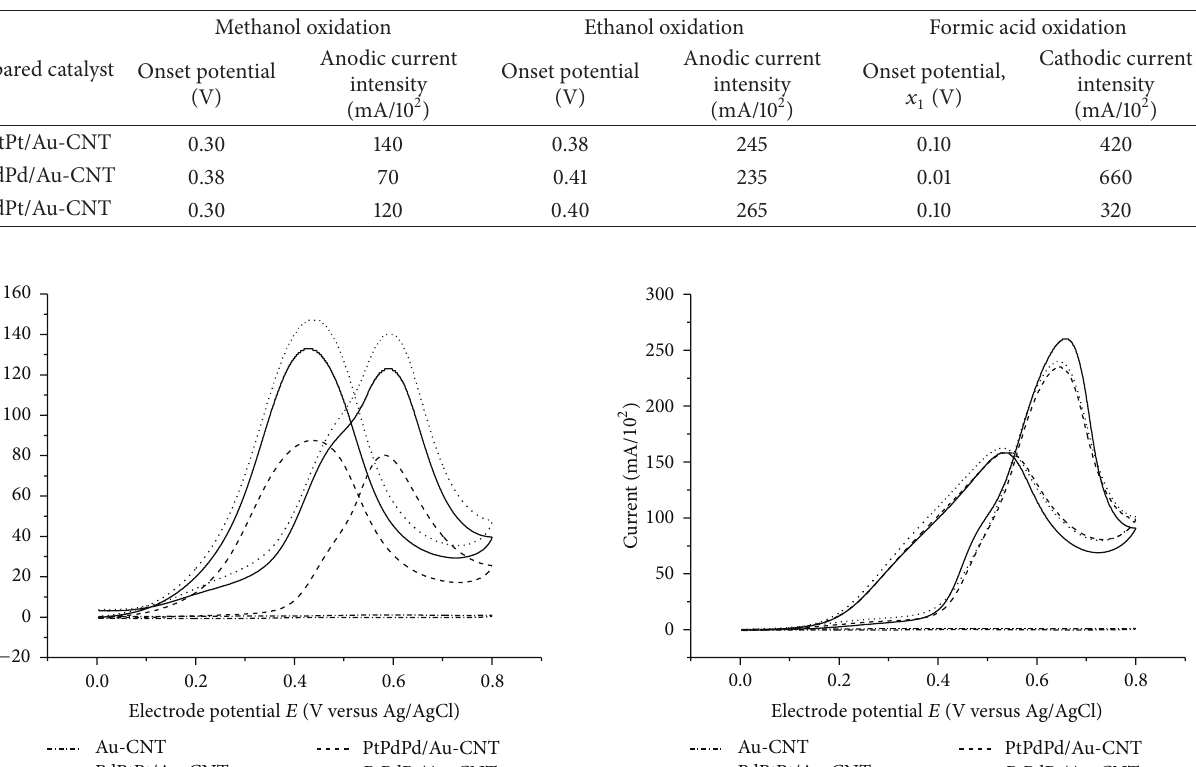
Table 1: Onset potentials and oxidation current intensities of PdPtPt/Au-CNT, PtPdPd/Au-CNT, and PtPdPt/Au-CNT in the potential range